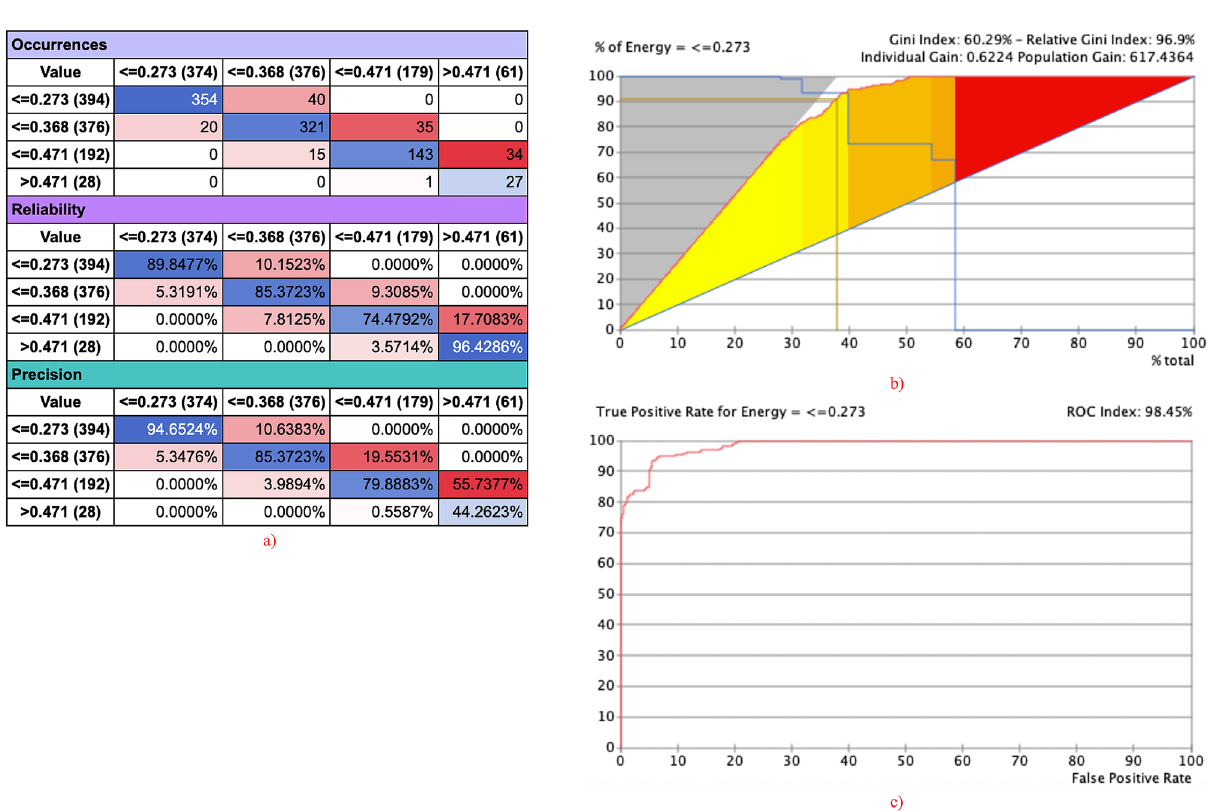
Figure 7. Network performance target evaluation energy node with other selected nodes ( a ) occurrence, reliability and precision report; ( b ) gain report of state ≤ 0.273, ( c ) ROC index of state ≤ 0.273.